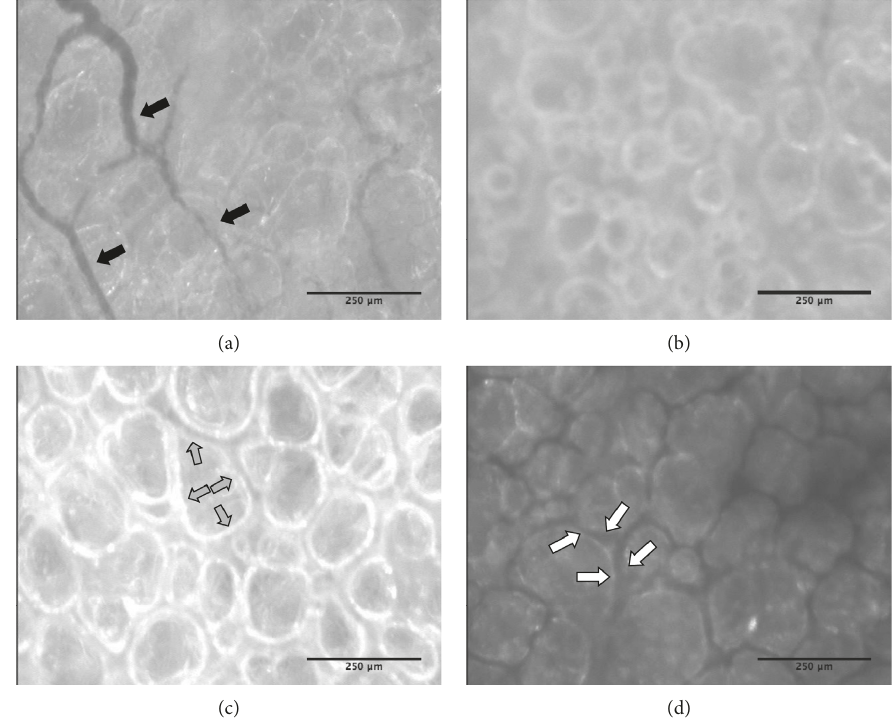
Figure 7: Porcine sidestream dark field imaging. Representative images are captured frames from a video recorded using the ImageJ software. (a) In situ normal pleural blood vessels before organ retrieval (black arrows). (b) In situ normal alveoli before organ retrieval. (c) Alveoli on EVLP in healthy, well-ventilated nonoedematous portions of the lung with the grey arrows inside an alveolus indicating the margin. (d) Alveoli on EVLP in haemorrhagic oedematous portions of the lung with the white arrows highlighting the interalveolar septum that contains haemoglobin giving it the black discolouration. Scale bar is